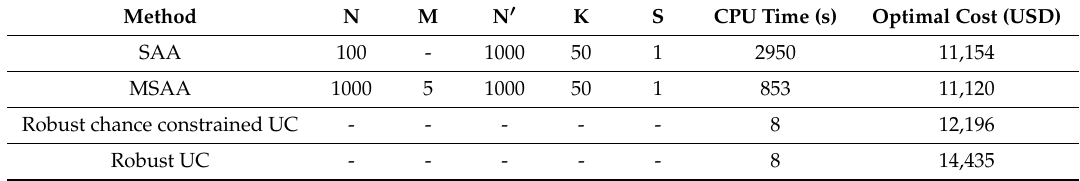
Table 5. Comparison of computing time between the MSAA, SAA, and the robust